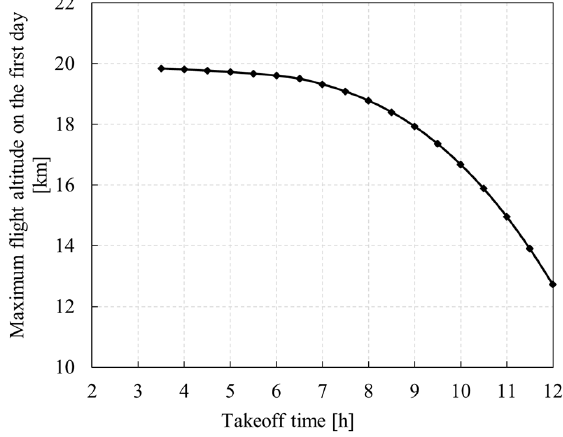
Figure 23. Variation of maximum flight altitude on the first day with takeoff time.